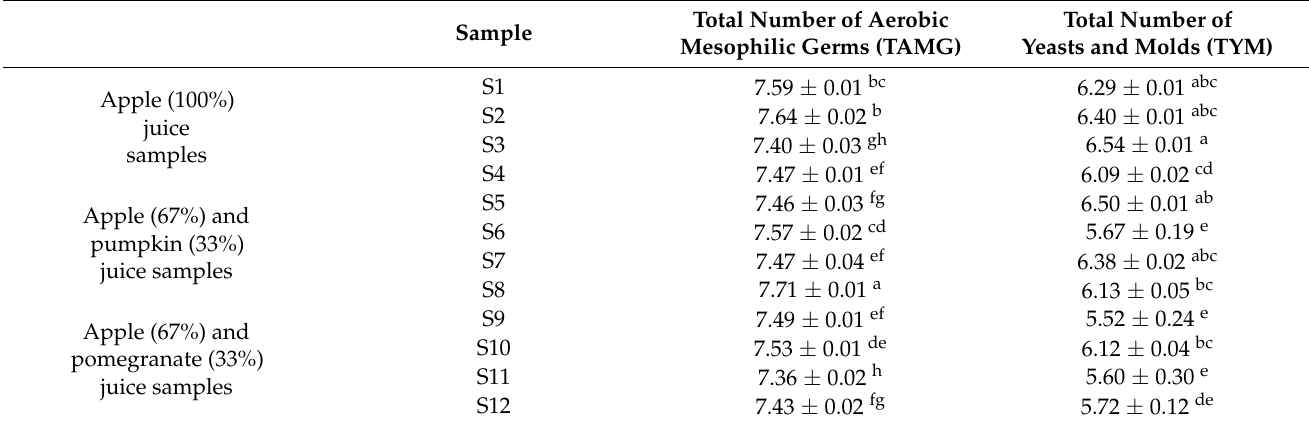
Table 6. Microbial counts of the fresh fruit juices (in log 10 CFU/cm 3 ).